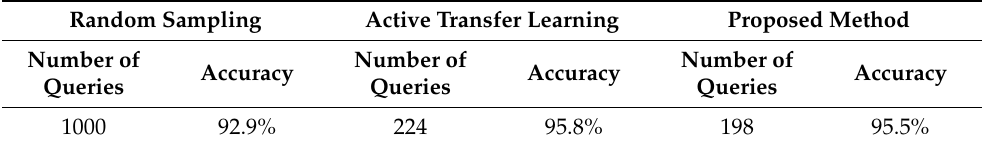
Table 5. Comparison of the number of queries and maximum accuracy (DNN, HCI-HAR).